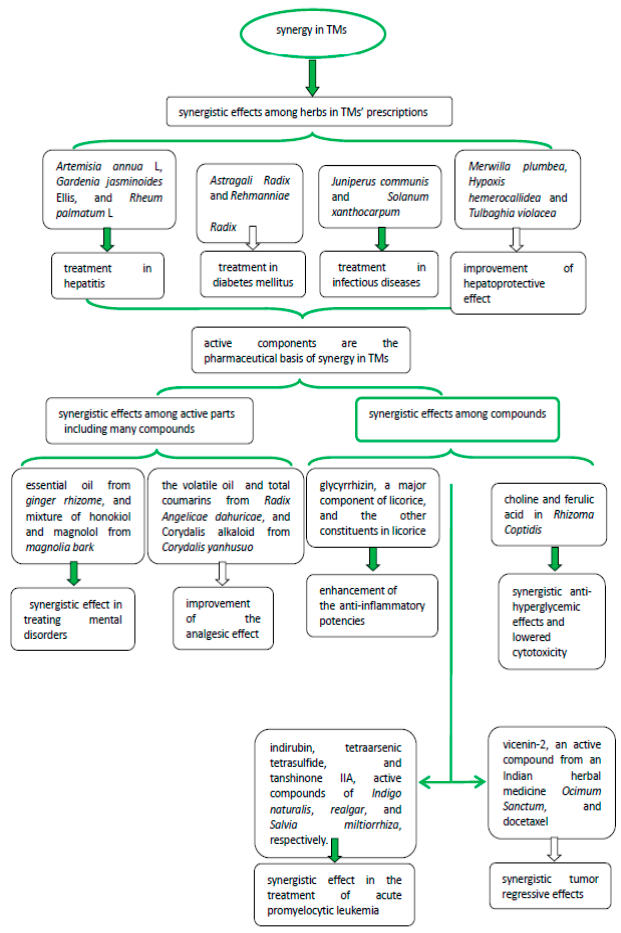
Figure 1. Synergistic effects in traditional medicines (TMs).